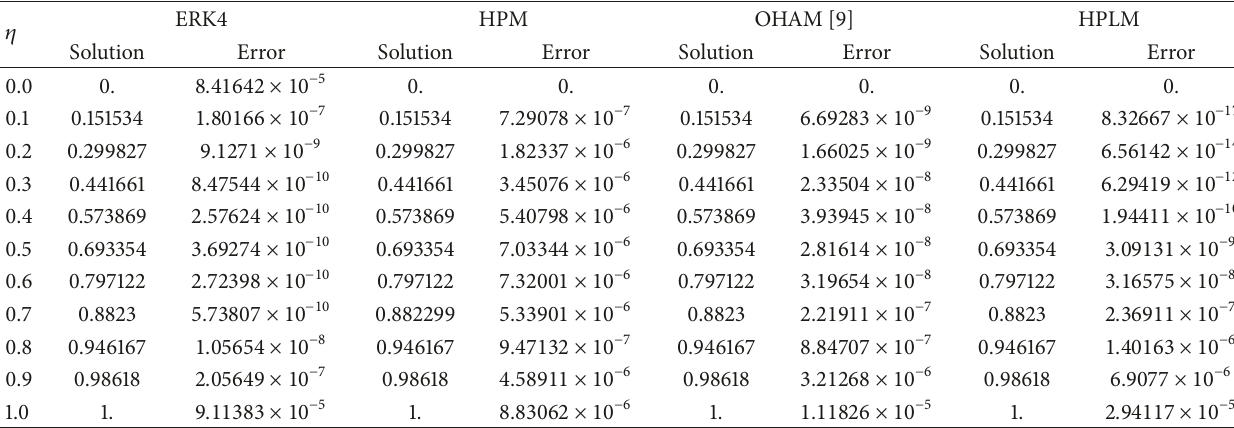
Table 2: Comparison of solutions along with absolute residual errors for various analytical and numerical schemes at 𝑅 = 0.3 .